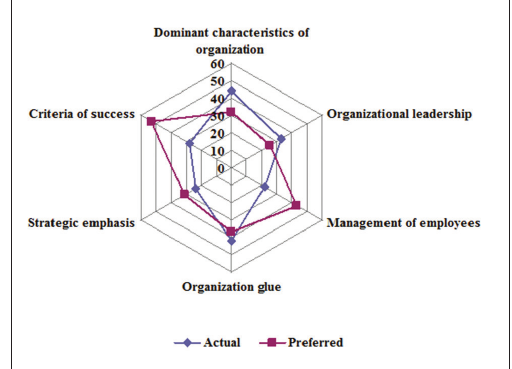
FIGURE 2. The key dimensions of the clan culture in PHC center A – actual and preferred